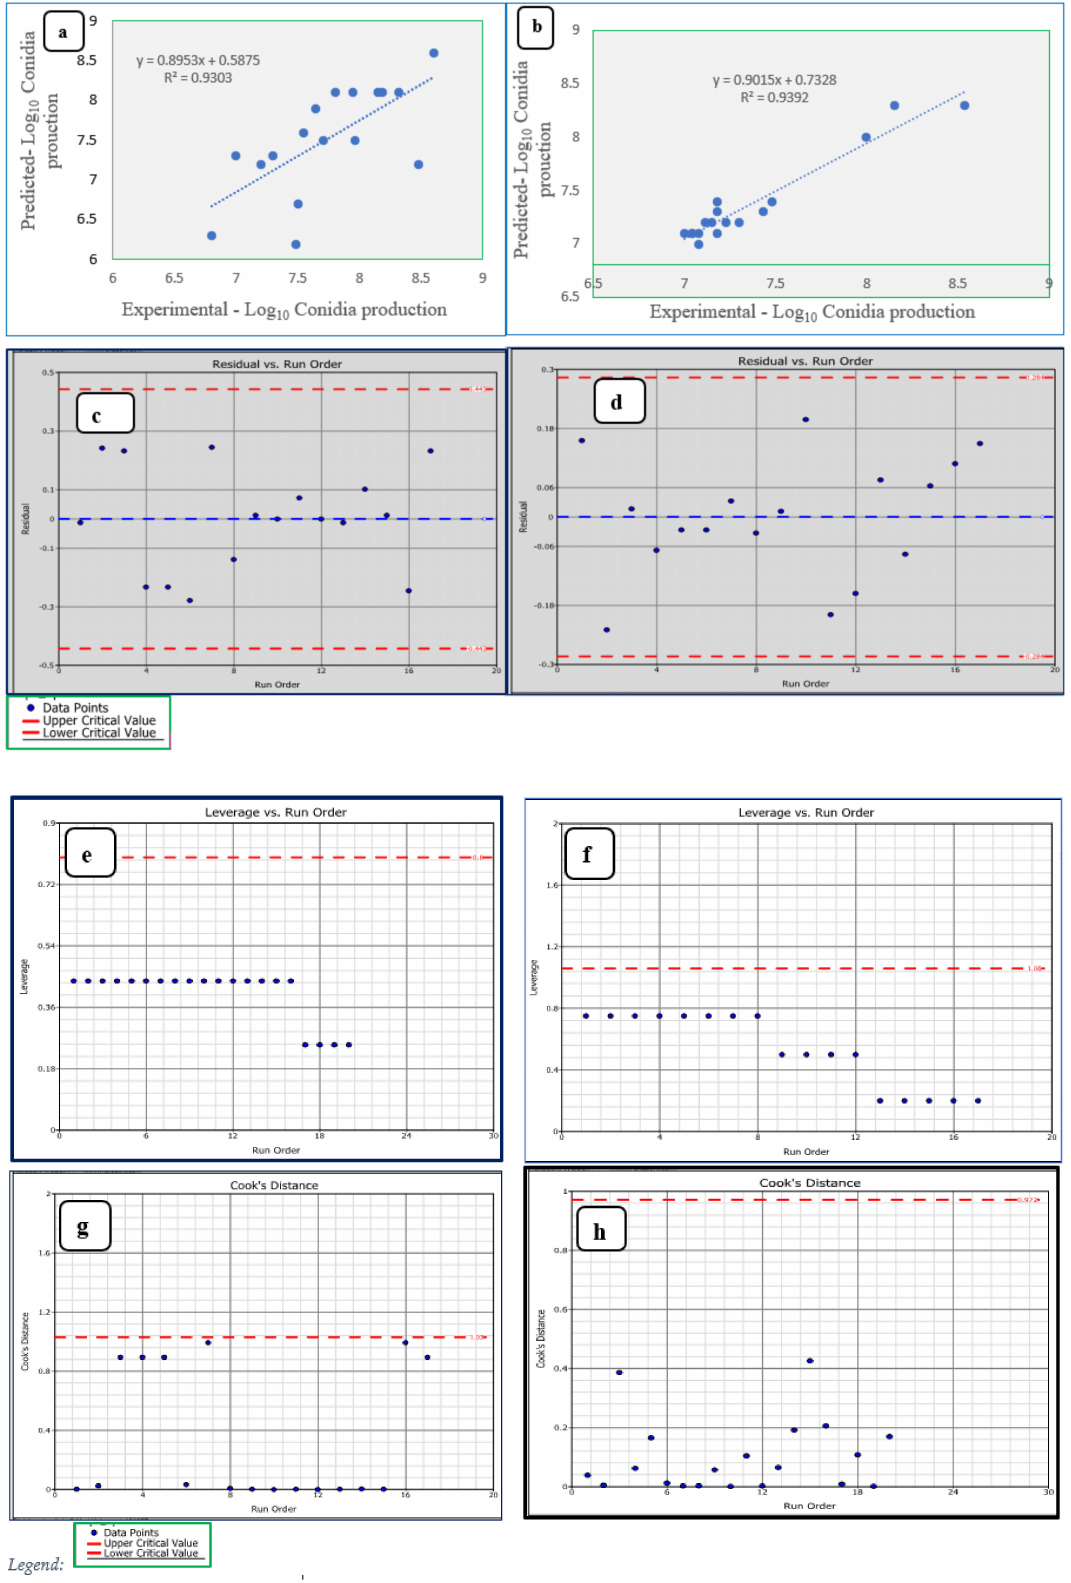
Figure 6. Diagnostic plots for Box–Behnken model adequacy ( a , c , e , g ) for T. asperellum AU131 and ( b , d , f , h ) for T. longibrachia- tum